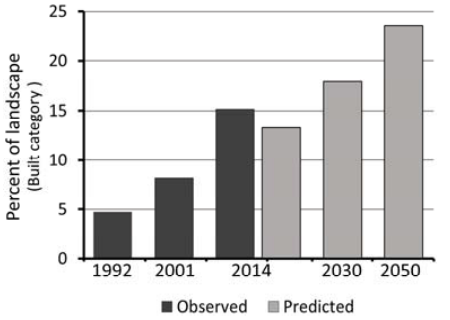
Figure 6. Observed and predicted quantities of built in the CMA.